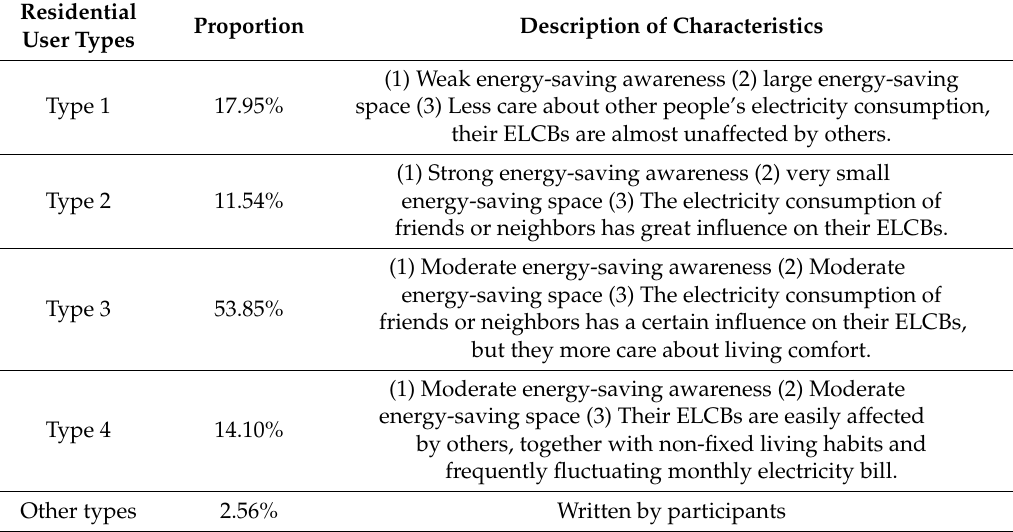
Table 2. Proportion and description of four residential user